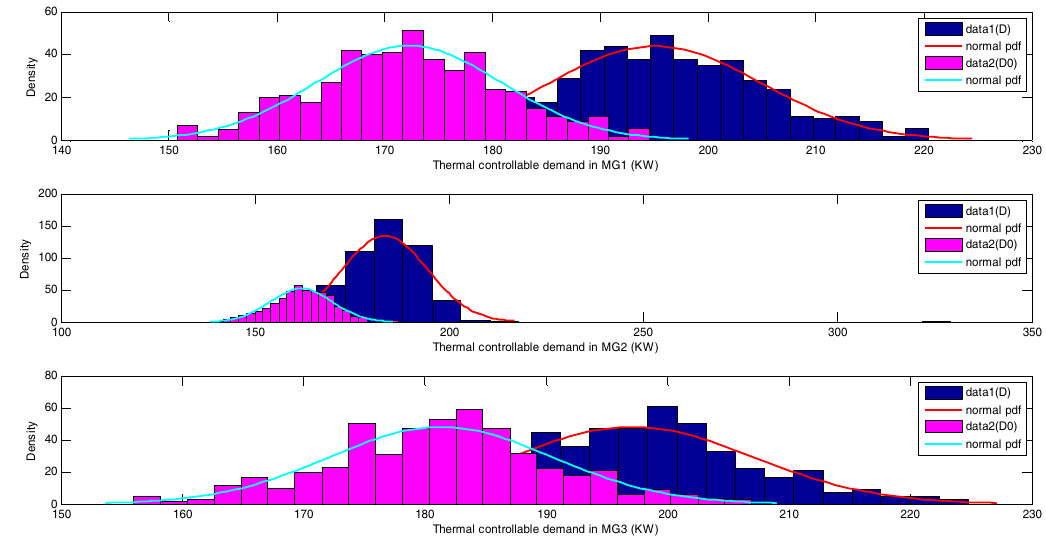
Figure 10. PDF of thermal responsive load profile under TOU policy in MCNMG. Top: MCMG1; Middle: MCMG2, Bottom: MCMG3.